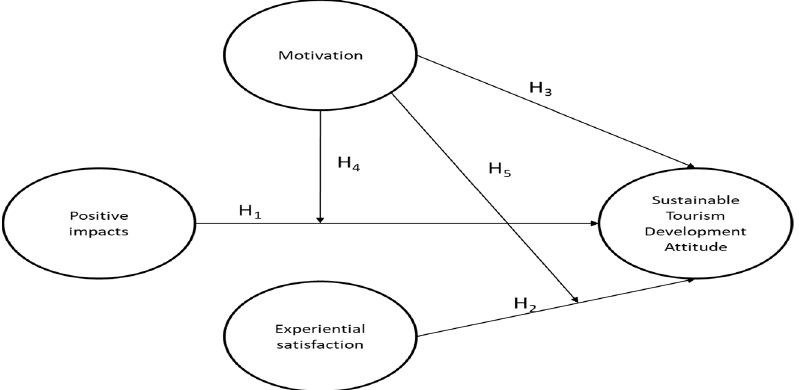
Figure 1. Conceptual model. Source: Own elaboration. While H1, H2 and H3 consider a direct influence between constructs, H4 and H5 include a moderator perspective.